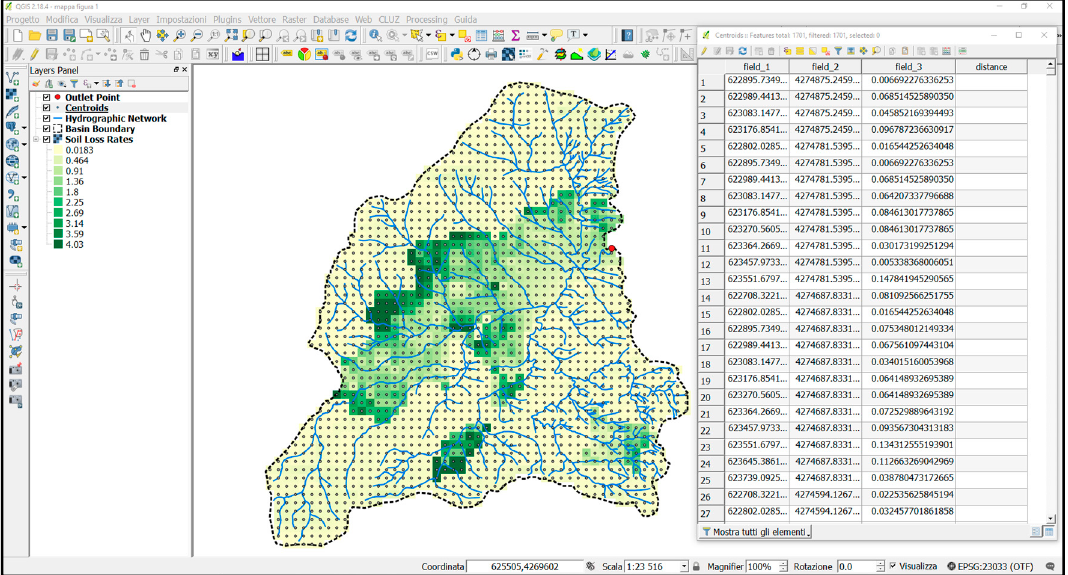
Figure 1. Soil-loss point layer (centroids) converted from raster map.